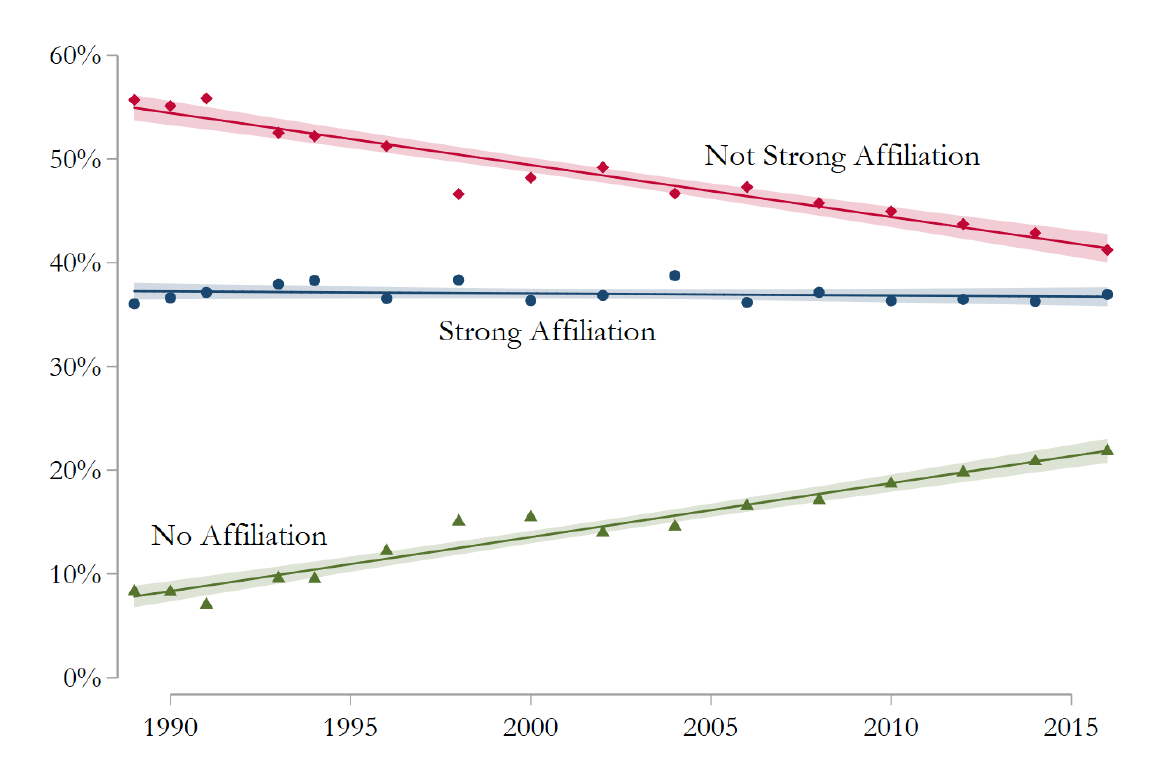
Figure 1: Strength of affiliation over time, General Social Survey. Source: General Social Survey, 1989 to 2016. Note: The GSS affiliation strength categories are created by using two items. First, respondents are asked their affiliation. If they have one, they are then asked whether they are a strong or not strong [their affiliation]. “Not strong” affiliation in the figure includes both those who said they had a “not strong” affiliation and those who volunteered “somewhat